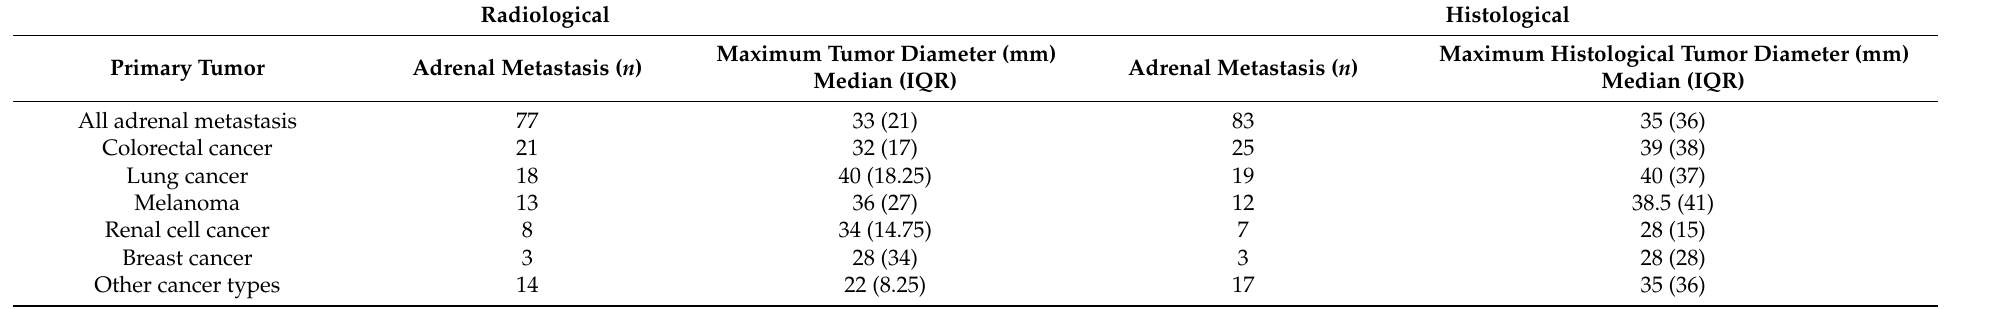
Table 2. Tumor size per tumor